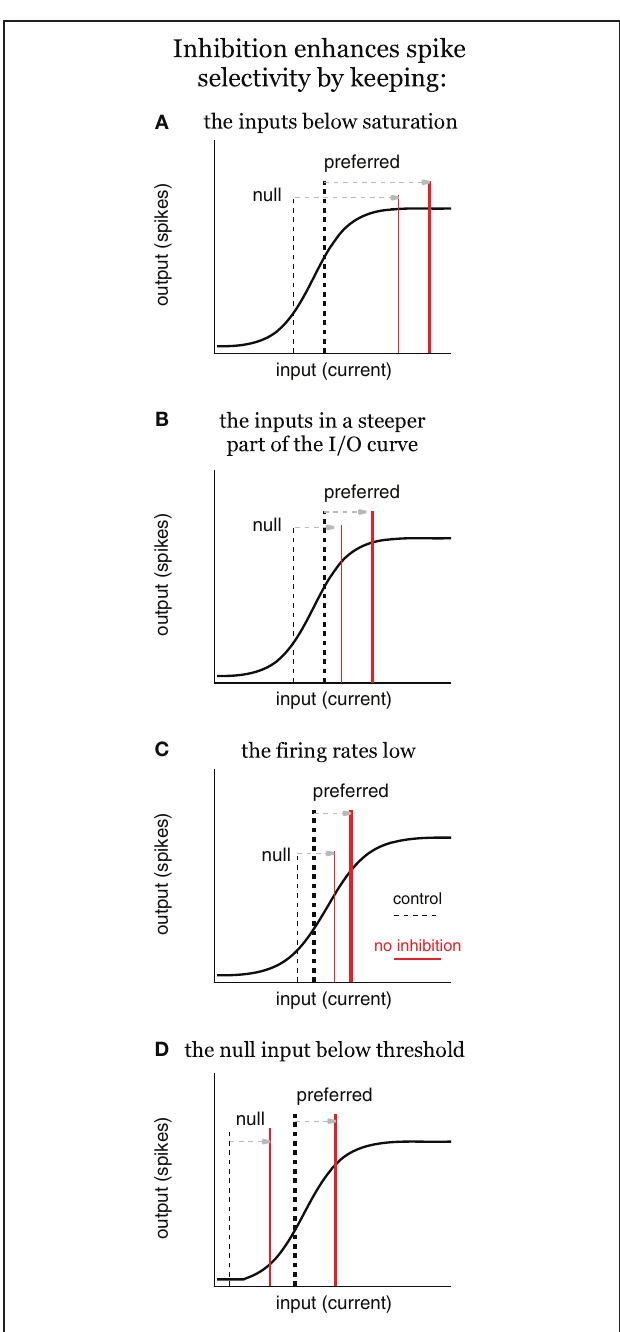
FIGURE 5 | Inhibition enhances spike selectivity by modulating gain, schematic. Input/output (I/O) schematics illustrate three scenarios in which inhibition enhances spikes selectivity by reducing spike rates and controlling gain, the ratio of output/input. In each panel, the solid black line represents the I/O curve, the dashed vertical lines represent the input current for the control condition (tall and thick for preferred; short and thin for null), and the red lines represent the input current with no inhibition. Inhibition enhances spike selectivity by: (A) keeping the inputs below saturation; (B) keeping the inputs in the steepest part of the I/O curve; (C) keeping the firing rates low; and (D) keeping the null input below threshold, where the gain is zero. In (C) , it is not required for inhibition to change the gain to enhance spike selectivity, although, it does in this